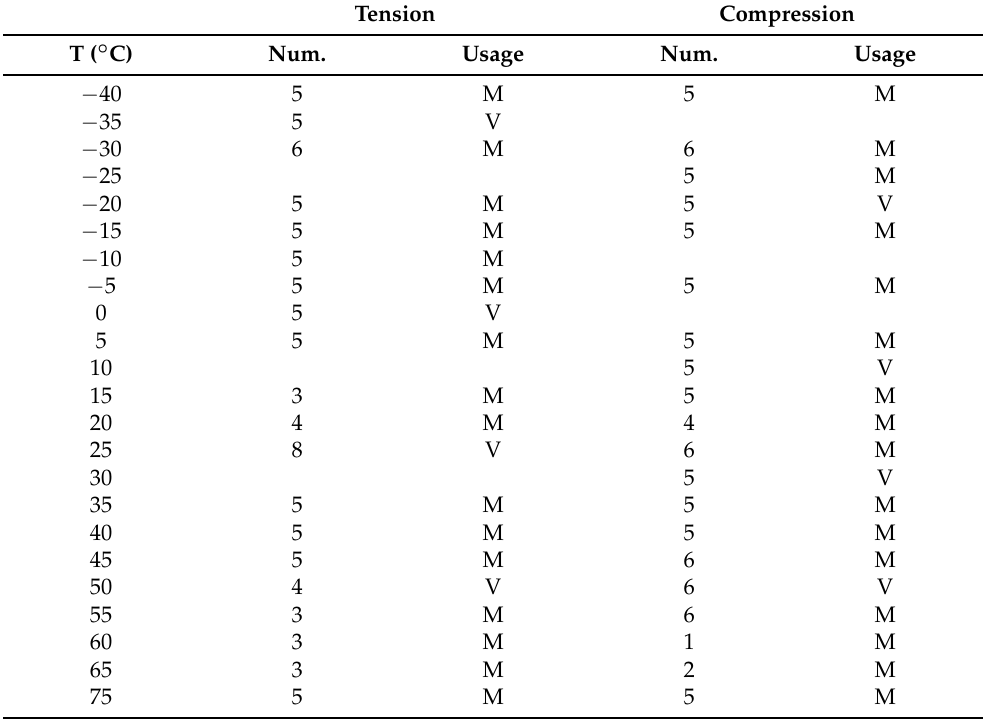
Table 1. Test temperature, the number of repeated specimens, and the usage of data. The symbols ‘M’ and ‘V’ denote modeling and validation, respectively. Striking lines denote no testing performed at that temperature. Tension Compression Num. Usage